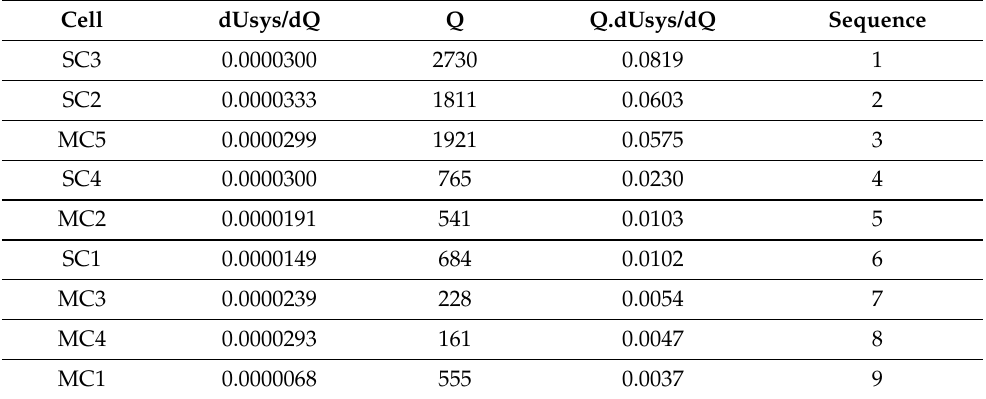
Table A4. Results from the Impact factor evaluation based on available reactive power resources and U sys for cell reactive power injection.